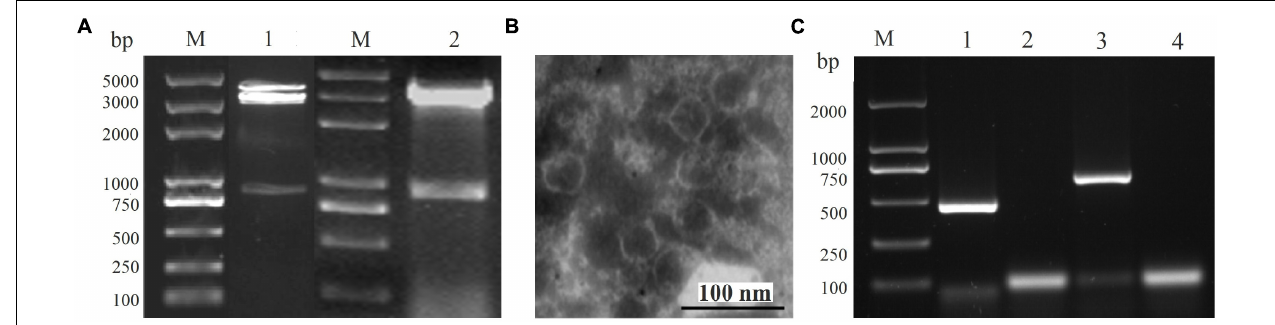
FIGURE 1 | Infection of Alternaria alternata chrysovirus 1 strain QY2 (AaCV1-QY2) and A. alternata magoulivirus 1 (AaMV1) in A. alternata QY21 strain. (A) Agarose gel electrophoresis analysis of the double-stranded RNA (dsRNA) extracted from the mycelium (lane 1) and virus particles (line 2), lane M is for markers. (B) Electron micrograph of purified particles of mycoviruses extracted from the strain QY21. The scale bar denotes 100 nm. (C) AaCV1-QY2 (lane 1) and AaMV1 (lane 3) in the strain QY21 were detected by reverse transcription-polymerase chain reaction (RT-PCR) using specific primers AaCV1-QY2f/r or AaMV1f/r directed to the